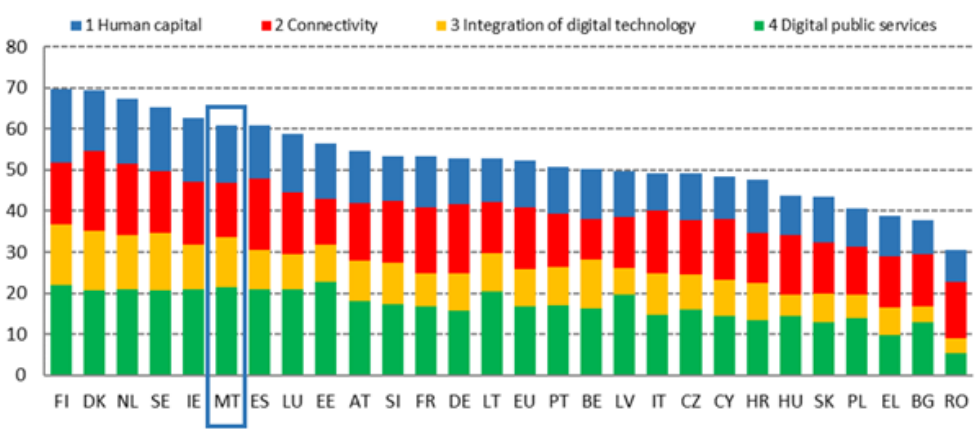
Figure 1. Digital Economy and Society (DESI) 2022